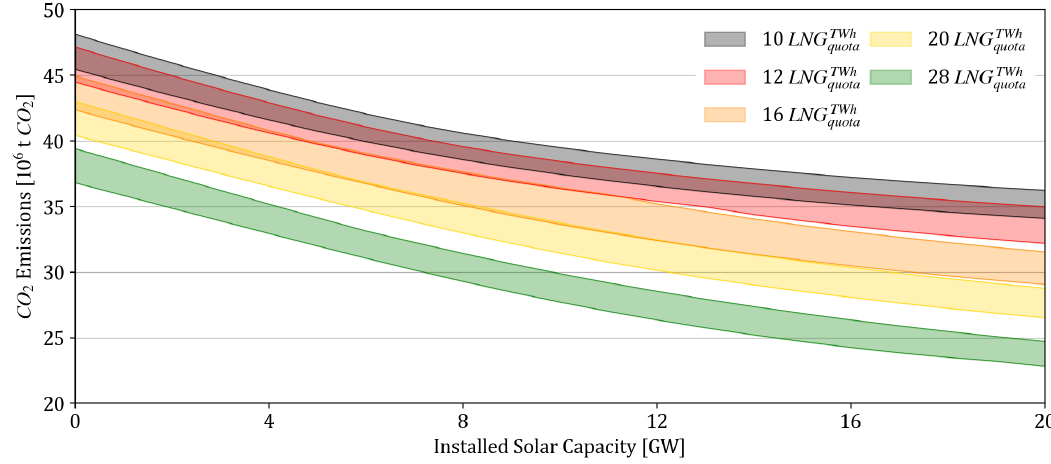
Figure 16. Range of CO 2 emissions for various scenarios in